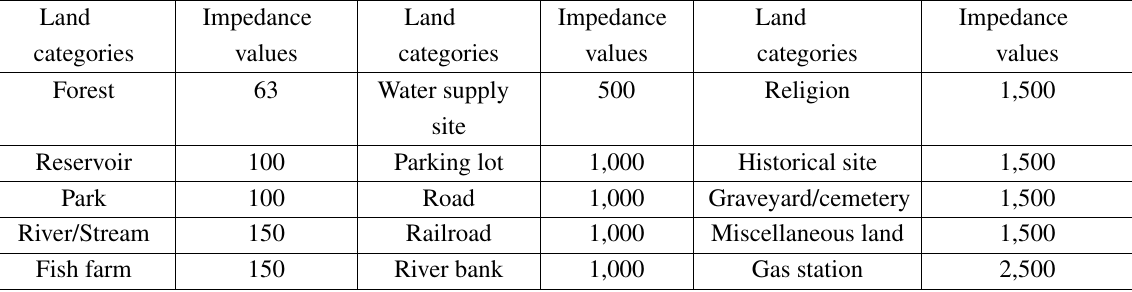
Table 3. Impedance values of land categories of cadastral